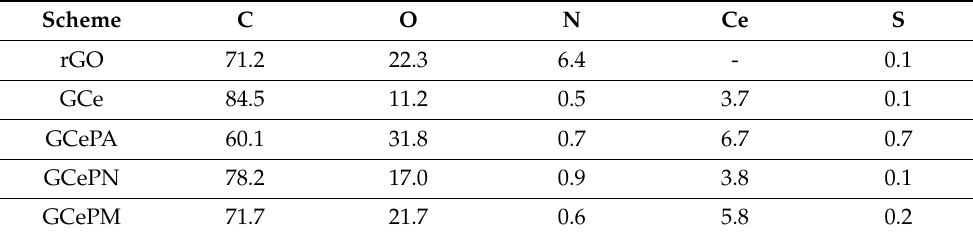
Table 2. EDX elemental percentages (C-O-N-Ce-S) for all samples.